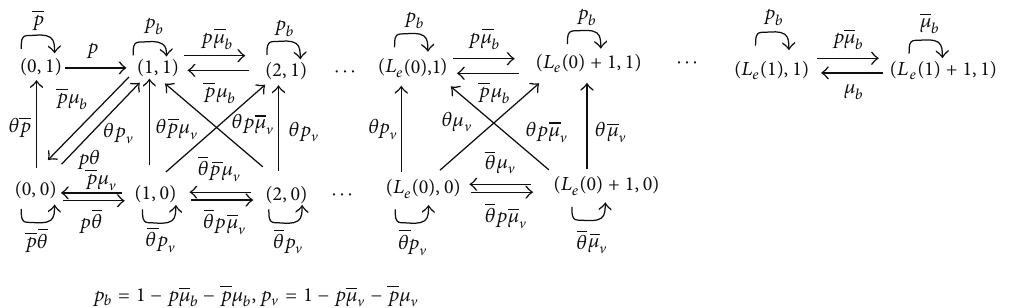
Figure 1: Transition probability diagram for the (𝐿 𝑒 (0),𝐿 𝑒 (1)) threshold